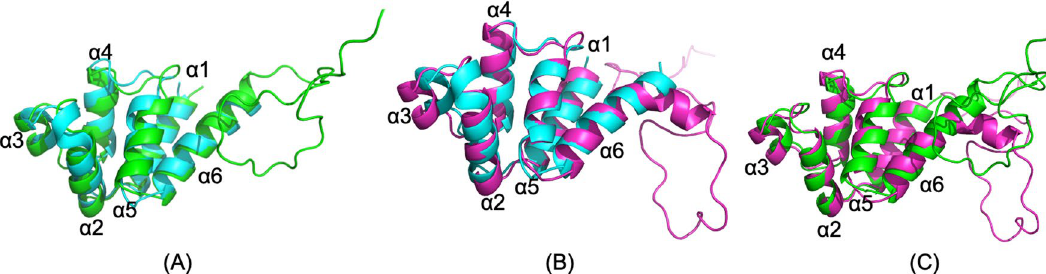
Figure 1. Superimpositions of ( A ) simulated free PEA-15, unphosphorylated (green) and NMR structure 2LS7 (cyan), ( B ) simulated free PEA-15pp, doubly phosphorylated p-S104, p-S116 (magenta) and NMR structure 2LS7 (cyan), and ( C ) simulated free PEA-15, unphosphorylated (green) and simulated PEA-15pp, doubly phosphorylated (magenta). Note that NMR structure 2LS7 contains only DED structure without the C-terminal tail. The simulated structure of unphosphorylated PEA-15 closely resembles the experimental NMR structure for the DED (RMSD 1.499 Å), while the simulated phosphorylated PEA-15pp has a very different conformation from the NMR structure (RMSD 2.027 Å). The simulated unphosphorylated PEA-15 and phosphorylated PEA-15pp also display conformational differences, with an RMSD of 1.994 Å. The molecular structures were visualized and generated using PyMOL version 2.4 (http:// www. pymol.